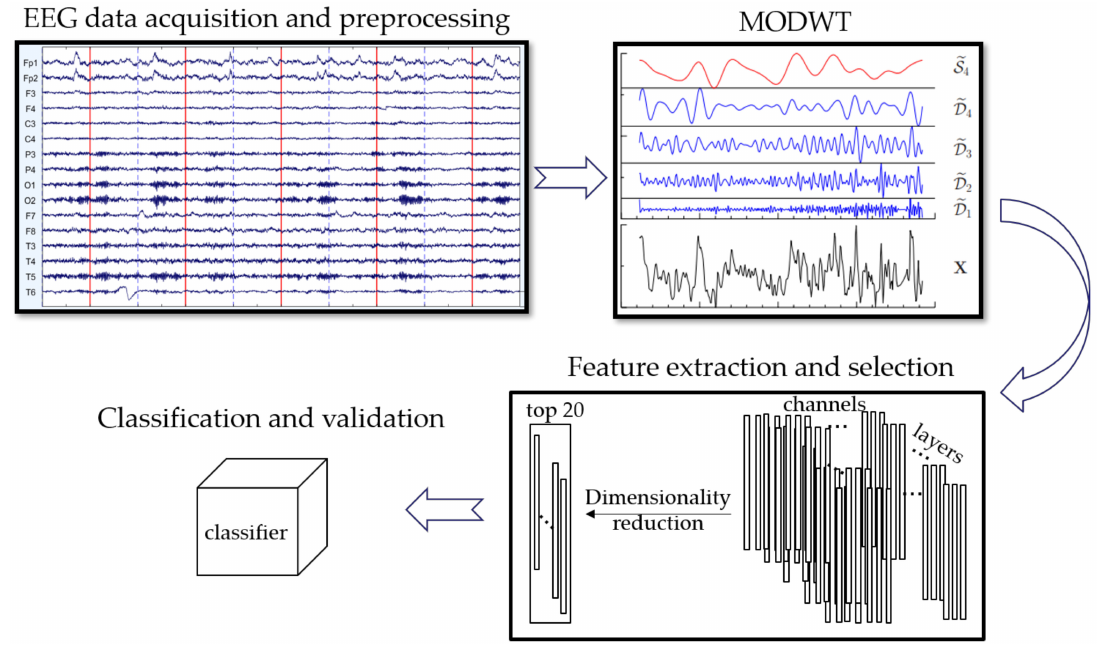
Figure 1. The flow diagram of the discriminant